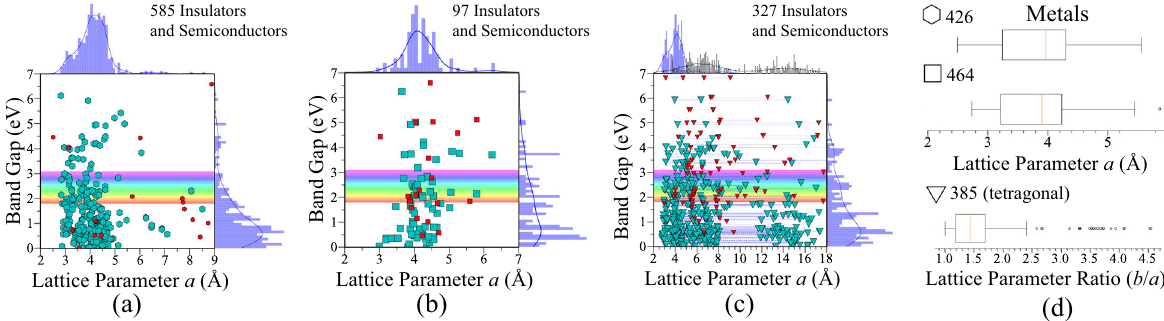
Fig. 5 Lattice vectors and bandgaps for the substrates. Semiconducting or insulating substrates identi fi ed are shown for ( a ) hexagonal, ( b ) square, and ( c ) tetragonal surfaces. For the tetragonal substrates in ( c ), the a and b lattice vectors are both plotted and connected with a dashed line, and the kernel density of the b lattice vectors is plotted in grey. 93 of the 106 commercially available insulating substrates identi fi ed are shown in red fi lled markers. For metallic substrates, ( d ) shows boxplots for the hexagonal and square surface structures and the b / a ratio of the tetragonal ones. The 23 monoclinic surfaces are not represented in these fi gures. The symmetry is classi fi ed using an in-plane lattice vector length tolerance of 1% and angle tolerance of 0.5 ˚ . Substrates containing f -valence elements are not